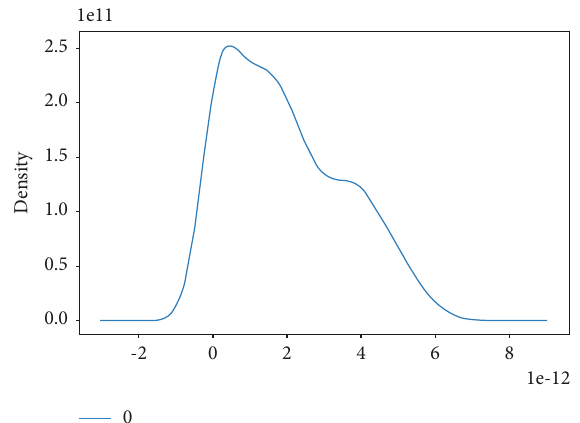
Figure 5: Probability of multivariate Gaussian with Gaussian pyramid 11 × 11.